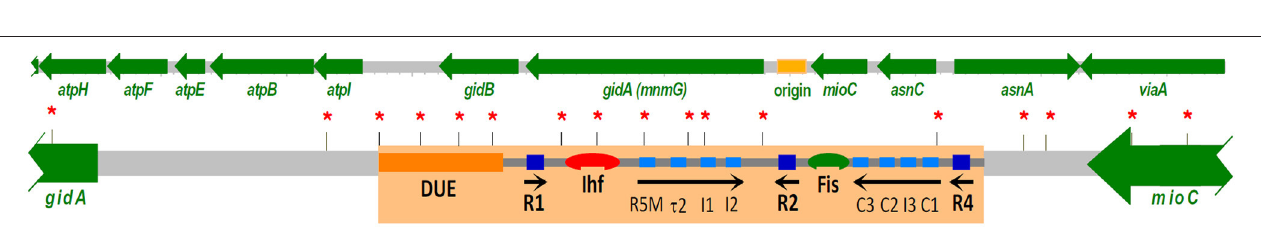
FIGURE 3 | The region of the E. coli chromosome carrying oriC , the origin of replication, and neighboring genes. A recent review presents a detailed walkthrough of the various binding sites in oriC and the interactions with the DnaA protein and other factors in forming the orisome that is required to initiate replication ( Leonard and Grimwade, 2015). DnaA boxes with high (dark blue boxes) and low (light blue boxes) affinity, respectively; positions of GATC sites (*). However, in an exponentially growing culture containing cells of all ages only the R1, R2, and R4 are bound by DnaA protein (Samitt et al., 1989).